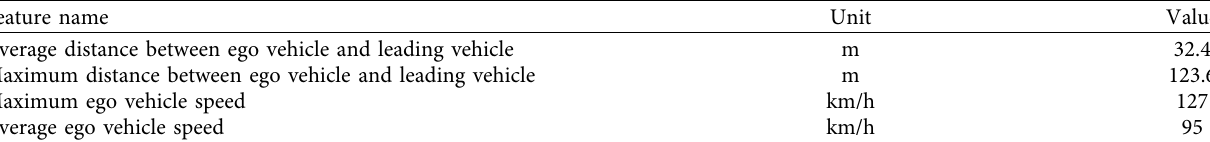
Table 2: The vehicles’ features.